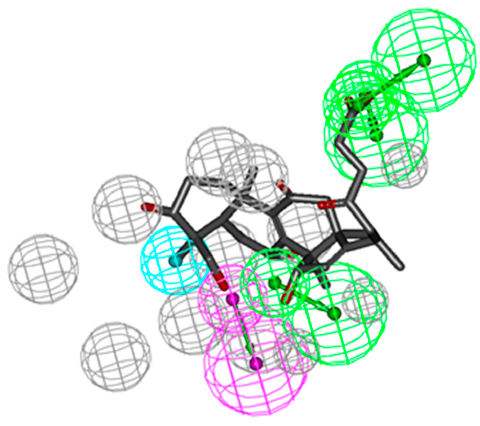
Figure 1. CDK2 SBP model (PDB: 1KE5) and molecular mapping of the Compound 3 .